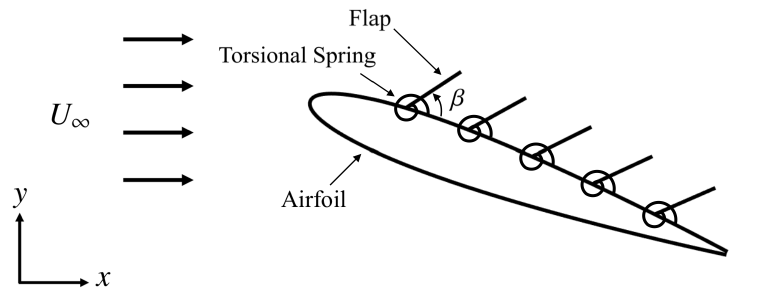
Figure 2. Schematic of the airfoil body with five torsional flaps fixed at 0.2 c , 0.35 c , 0.5 c , 0.65 c and 0.8 c